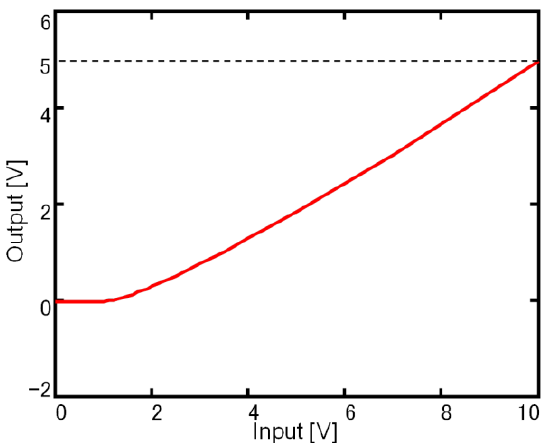
Figure 5. Fundamental characteristics of the negative-channel metal oxide semiconductor (NMOS) source follower circuit fabricated without using tetraethyl orthosilicate (TEOS).